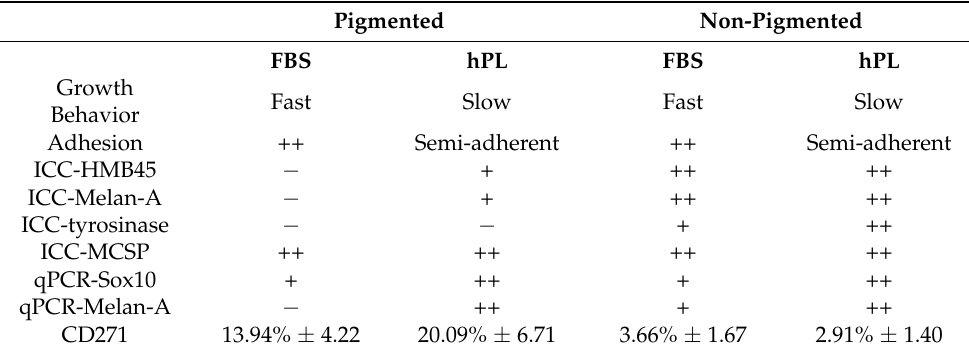
Figure 3. ICC for melanoma cell markers of cultivated MUG Mel3 cell lines. HMB45 staining: MUG Mel3 PF weak staining, MUG Mel3 Ph, MUG Mel3 NPF, and MUG Mel3 NPh strong staining. Melan A: MUG Mel3 PF weak staining, MUG Mel3 Ph, MUG Mel3 NPF, and MUG Mel3 NPh strong staining. Tyrosinase: MUG Mel3 PF and MUG Mel3 Ph weak staining, MUG Mel3 NPF and MUG Mel3 NPh strong staining. MCSP: highly expressed in all four cell lines. For each tested antigen, the corresponding IgG isotype control (negative control) was applied. Table 1. Overview of melanoma marker. ICC markers HMB45, Melan-A, tyrosinase, and MCSP, and mRNA levels for SOX10, Melan-A, and % CD271 are summarized for all four cell lines. ICC data are depicted in Figure 3, qPCR data in Figure 4. For normalization of qPCR data, GAPDH, and β-Actin were used as housekeeping genes. qPCR and CD271 levels were obtained from three independent experiments.